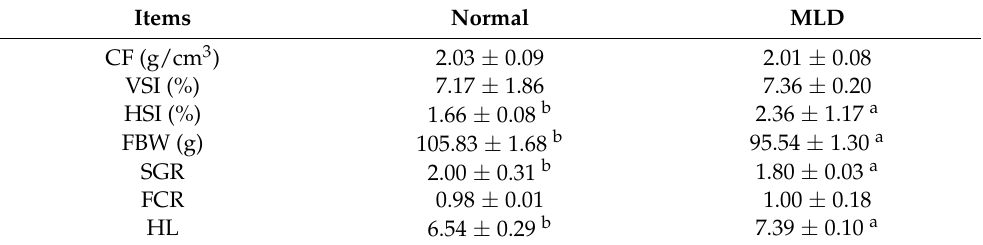
Table 3. Changes of MLD on morphometric parameters of largemouth bass (means ± SEM).